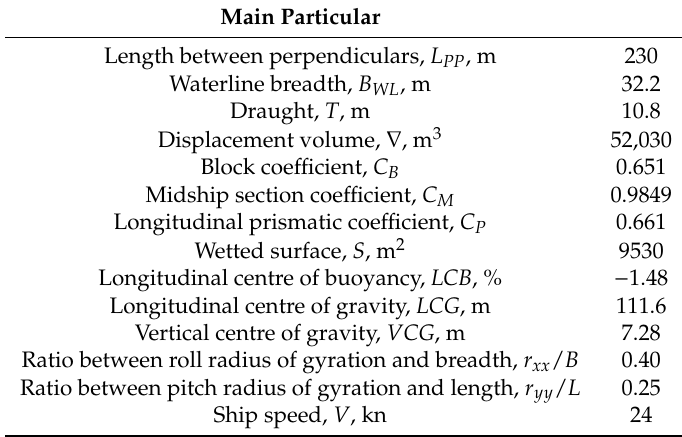
Figure 1. 3D model of Kriso Container Ship (KCS). Table 1. The main particulars of Kriso Container Ship (KCS).